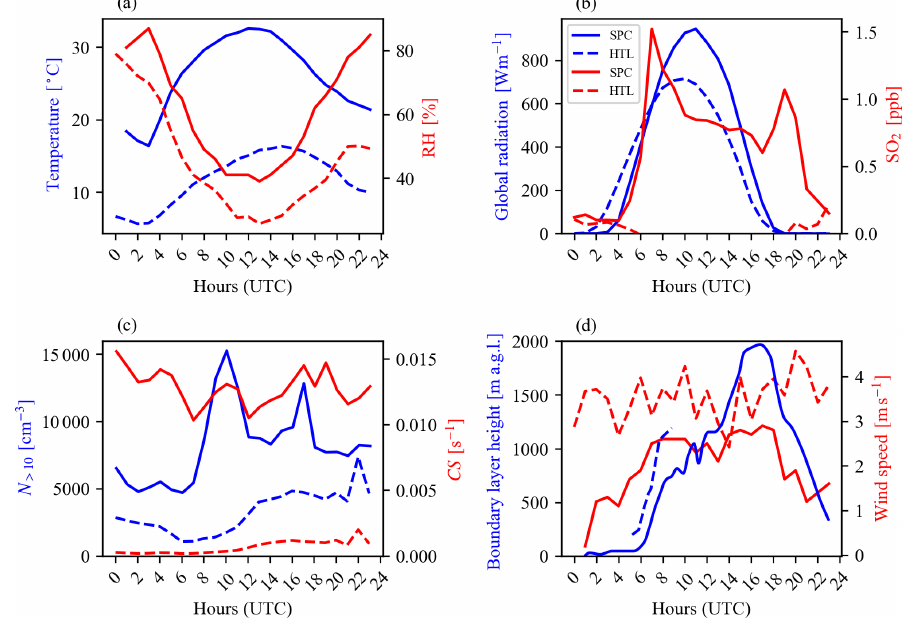
Figure 3. Ground-based measurements of diurnal variation in (a) temperature and relative humidity, (b) global radiation and SO 2 concentra- tion, (c) > 10nm particle number concentration and condensation sink (CS), and (d) mixed layer height in SPC on 28 June 2012 and in HTL on 8 May